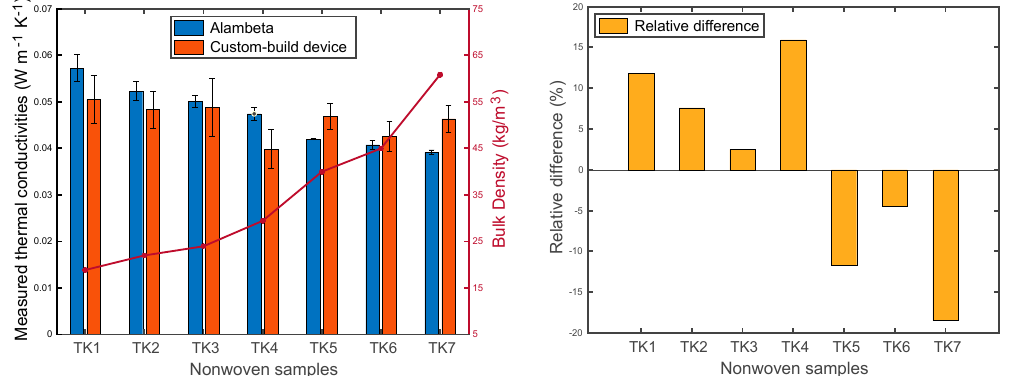
Figure 11. Comparison of the results from two different devices.